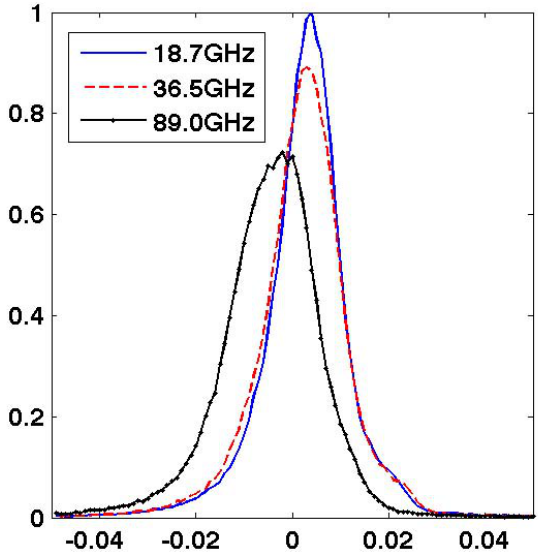
Fig. 1. Normalized histogram of the difference between SSM/I and AMSR-E products at close to 18.7, 36.5, and 89.0GHz (horizontal polarization) for July